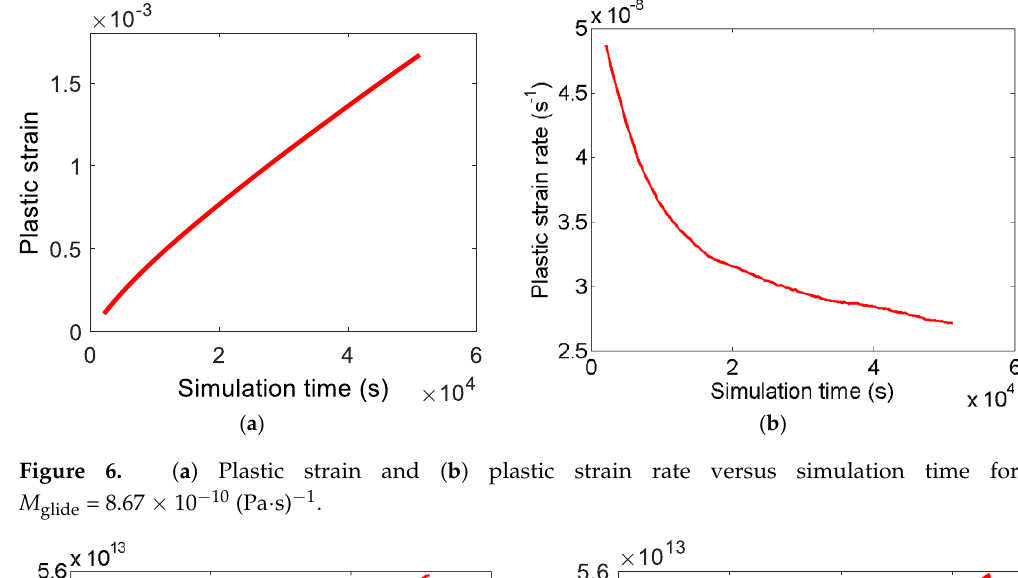
Figure 5. Dislocation density versus ( a ) simulation time and ( b ) plastic strain for deformation with original mobility value M glide = 2.89 × 10 −13 (Pa·s) −1 .